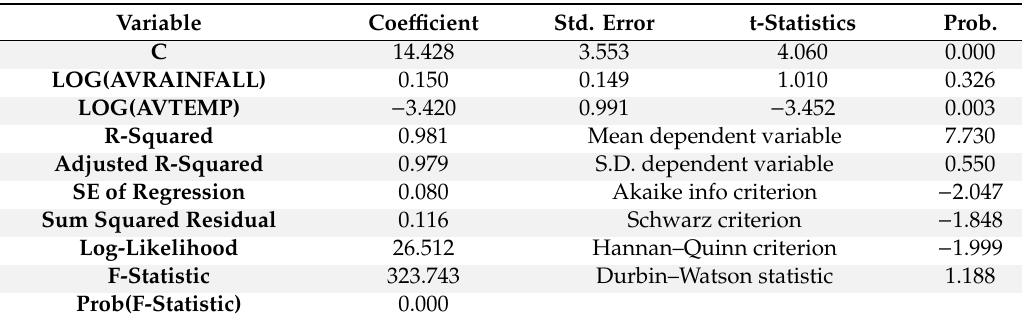
Table 3. Long run relationship (OLS